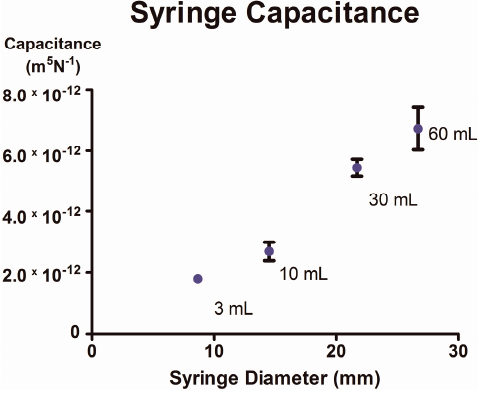
Figure 5. Fluidic capacitance increases significantly with increasing syringe volume. Capacitance values were averaged for individual syringes using data collected at multiple volumetric flow rates (ranging from 10 to 40 μ L/min). All values are derived from time series data containing >6 oscillations, with five replicates ( p < 0.0002). Error bars represent the 95% confidence intervals of all capacitance values obtain over multiple inflow rate